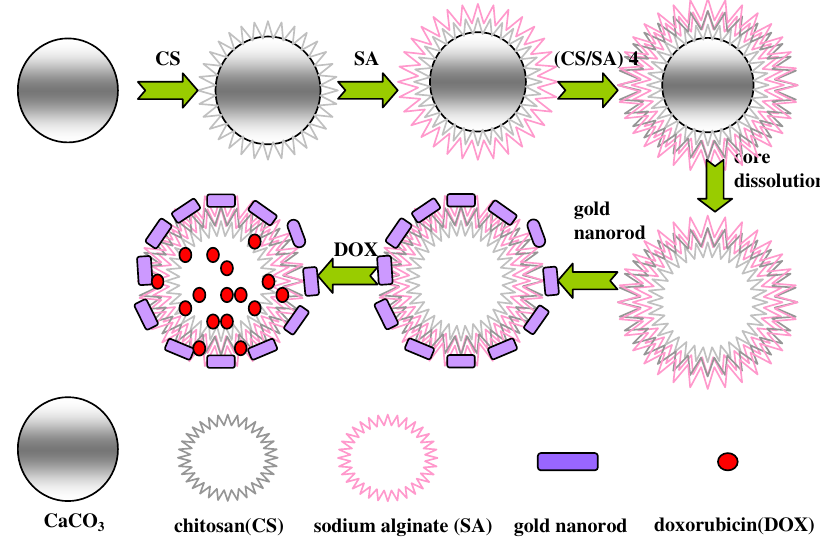
Fig. 1. Schematic of the fabrication of gold nanorod-covered DOX-loaded hollow CaCO 3 microcapsules.